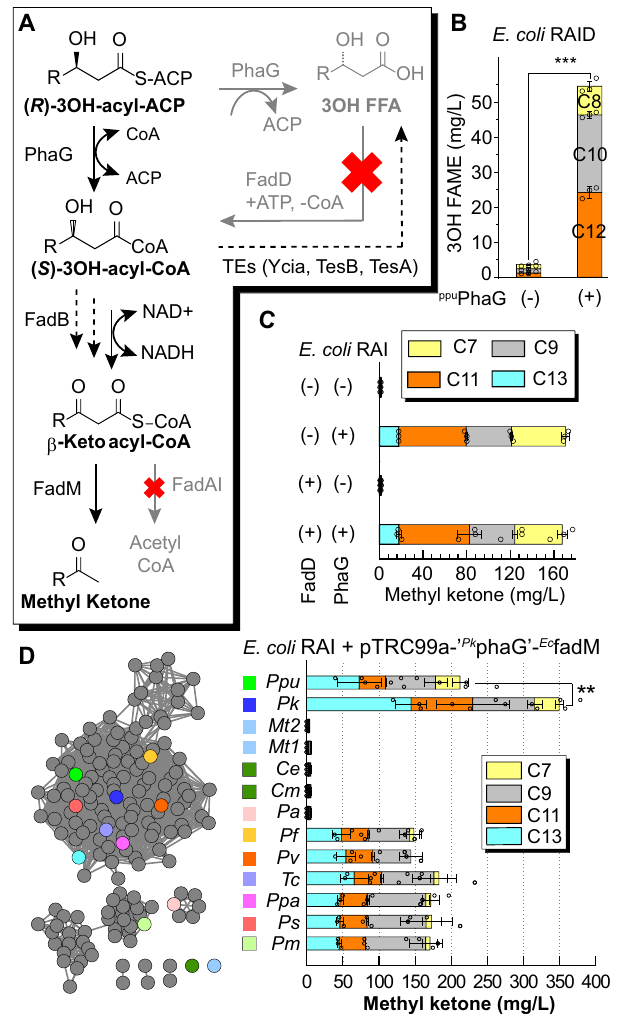
Fig. 2 PhaG transacylase activity in vivo. A Metabolic pathways used to test for the presence of PhaG-dependent thioesterase and/or transferase activity. B In cells lacking FadR, FadA, FadI, and FadD ( E. coli RAID harboring pTRC99a- Ppu phaG ), PhaG expression leads to the production of 50mg/L medium-chain 3-hydroxy fatty acids ( n = 3 biologically independent samples). These products could be generated by either direct PhaG thioesterase activity on medium-chain acyl-ACPs or by CoA thioesterase activity on stranded pools of 3-hydoxyacyl-CoAs made via PhaG transferase activity. *** P = 0.0005 was analyzed based on student two-tailed t test assuming unequal variances. C Co-expression of PhaG, and FadM in E. coli RAI (MG1655 Δ fadR Δ fadA Δ fadI harboring pTRC99a- Ppu phaG - Ec fadM ) results in the production of 150mg/L of medium-chain methyl ketones ( n = 3 biologically independent samples). FadD expression did not impact methyl ketone production indicating that free fatty acid activation is not required for PhaG-dependent methyl ketone production. D A two- dimensional cluster map created with the Enzyme Similarity Tool 37 displays the sequence similarity of PhaG variants tested in bioprospecting studies. Quantitative pairwise percent amino-acid identity of each homolog can be found in Supplementary Figure 2. Colored boxes and dots are used to indicate the sequences tested. Mean methyl ketone titers for constructs of PhaG homologs using E. coli RAI harbor pTRC99a- ‘ Ppu phaG ’ - Ec fadM ( n = 3 biologically independent samples). All cultures were grown in Clomburg medium containing 20g/L glycerol at 30°C and shaking at 250 r.p.m. ** P = 0.009 was analyzed based on student two-tailed t test assuming unequal variances. All data represent the mean ± s.d. of biological triplicates. Source data underlying B – D are provided as a Source Data fi